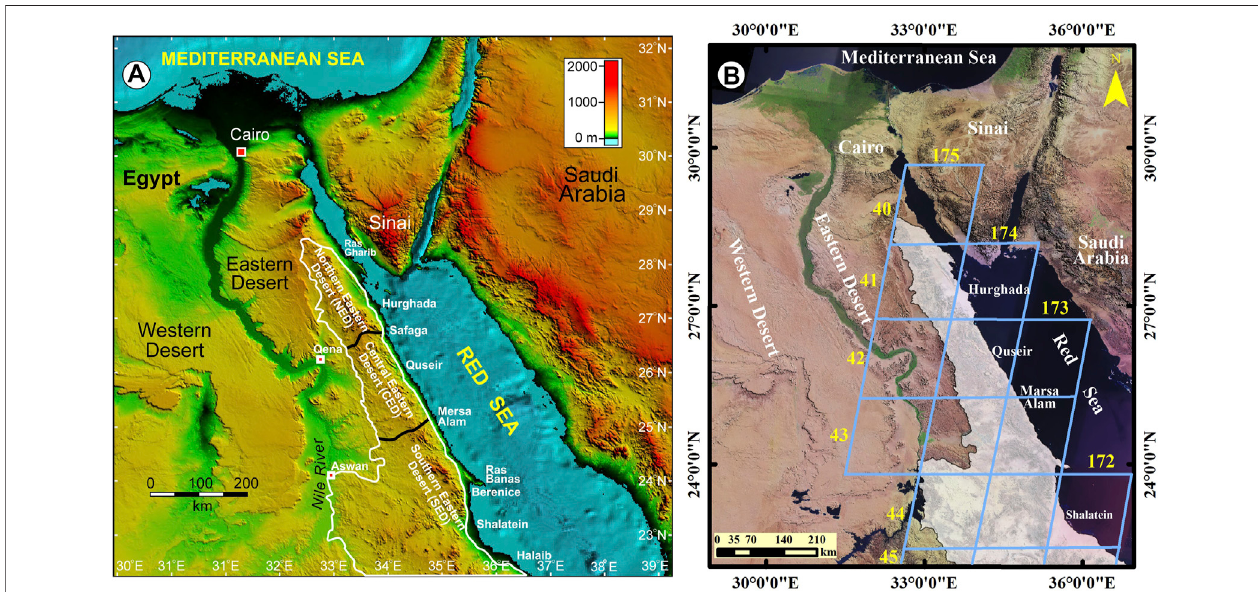
FIGURE 2 | (A) Digital elevation and bathymetric model of the northern Red Sea, Gulf of Suez, and Gulf of Aqaba region (NOAA, 2016), showing outline of Eastern Desert basement rocks (white) and the traditional three-fold subdivisions of the ED into North Eastern Desert (NED), Central Eastern Desert (CED) and South Eastern Desert (SED). (B) Satellite image showing the extent of the Eastern Desert basement domains (white polygon) and Path/Raw of the fi fteen Landsat-8 (OLI/TIRS) images used in the present